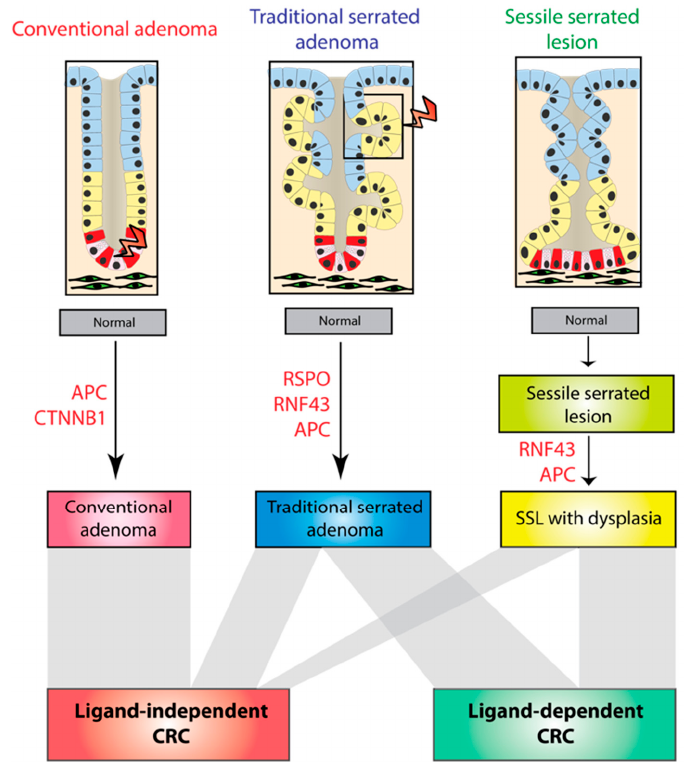
Figure 2. Molecular pathogenesis of different colorectal precursor subtypes. Colorectal cancer develops fromthreetypesofpre-cancerouspolyps: conventionalandserratedadenomas—dividedintotraditional serrated adenomas (TSAs) and sessile serrated lesions (SSLs). Conventional adenomas are driven